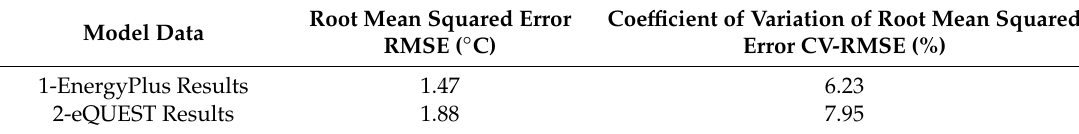
Table 4. Error Indices Calculated to Evaluate the Predicted Model against Measured